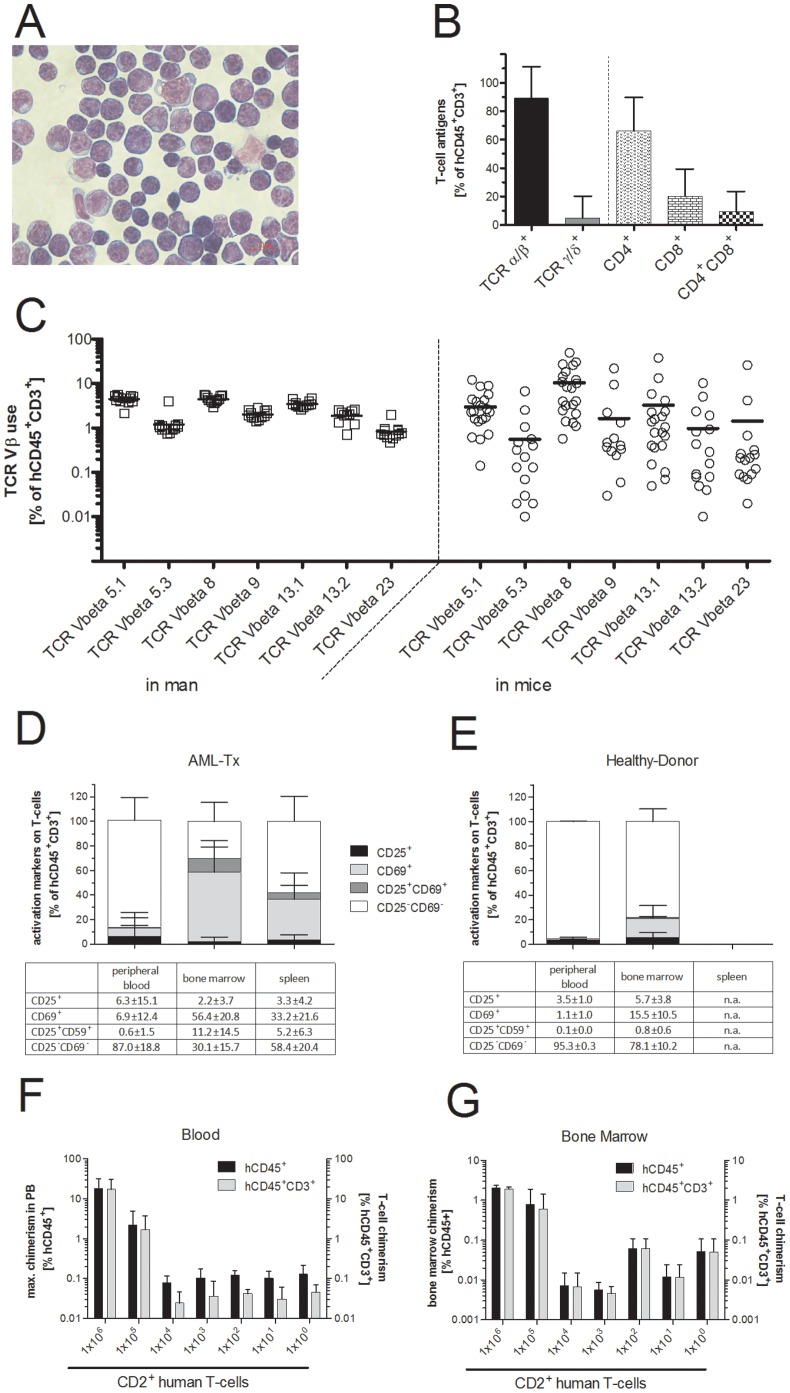
Human CD3+ cells in NSG recipient mice are polyclonal activated T lymphocytes.(A) Human CD3+ cells are morphologically diverse. Sorted human CD45+CD3+ cells (sort purity: 98.6%) isolated from the bone marrow of a NSG recipient mouse that had received 5×106–107 freshly isolated MNCs from AML #10 three weeks before were cytospun and stained according to May-Grünwald Giemsa. (Graft phenotype in the recipient: bone marrow: 35% hCD45+; composition of human leukocytes: CD3+ = 93%, CD19+ = 0.8%, CD33+ = 0.8%; surface antigens on CD3+ cells: CD4+ = 80%, CD8+ = 14%, CD4+/CD8+ = 3%, TCRα/β+ = 99%, TCRγ/δ+ = 0.02%). Photograph is representative for 6 different AML samples. Scale bar indicates a section of 10 micrometers. (B) Human CD3+ cells are identified as T lymphocytes by the surface expression of the T cell receptors (TCRs) and co-receptors. Graph shows a summary of the expression of TCRα/β or TCRγ/δ, and the expression of CD4 and CD8 on CD3+ cells the bone marrow of NSG mice that were transplanted with AML-MNCs as described in (A) (Within CD3+ cells: TCRγ/δ: 5.0±15.2%, TCRα/β: 89.2±22.1%; Within TCRα/β+ cells: CD4+ CD8−: 66.2±23.6%, CD4− CD8+: 20.2±19.2%, CD4+ CD8+: 9.3±14.5%.) (C) Plot shows the frequency of indicated Vβ segments used in human α/β T cell receptors on T cells in the blood of healthy controls (‘in man’) and in the bone marrow of NSG mice that had received MNCs from AML patients as described in (A, ‘in mice’). Frequencies based on human CD45+ CD3+ cells are shown. (D) Bar graph shows the frequency of human T lymphocytes (hCD45+CD3+) that express CD25 and CD69 in blood, bone marrow and spleen of NSG mice that were transplanted with 107 MNCs from AML patients 9.7±2.2 weeks before. N = 53 for all groups. (E) Bar graph shows the frequency of T lymphocytes that express CD25 and CD69 in the peripheral blood (4.7±0.3% of T lymphocytes) and bone marrow (21.9±10.2%) of healthy donors. N = 3 for all groups. (F) Maximum blood chimerism was determined after the transplantation of titrated numbers of CD2+ T cells that were sorted from the peripheral blood of a healthy donor. Donor-cell chimerism ≥0.1% hCD45+ (considered T cell engraftment, left y-axis) was reached only if ≥105 CD2+ cells were transplanted. Virtually all engrafted human leukocytes expressed CD3 (% hCD45+CD3+, right y-axis). Mean and standard deviation are shown. (G) Plot depicts donor-cell chimerism in the bone marrow of NSG recipient mice as described in (D). Mean and standard deviation are shown.